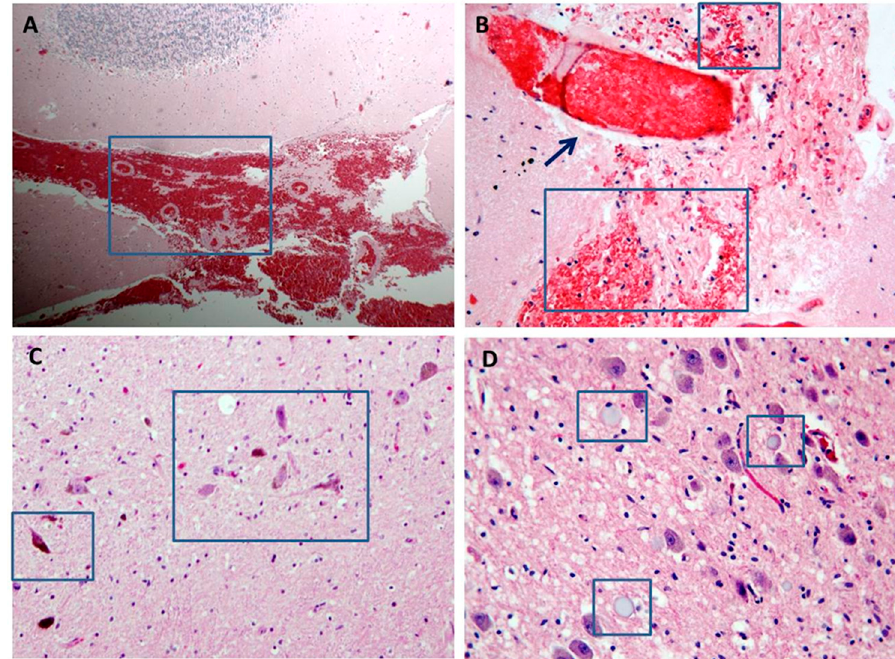
Figure 3. Brain histology from high voltage electrocution death. ( A , B ): massive cerebellar and brain hemorrhage respectively (blue box indicates the detail) with intra-vessel coagulopathy in ( B ) (black arrow indicates the detail) (H&E stain ×10 A; ×20 B). ( C ): dark neurons as sign of ischemic neuronal damage due to vasoconstriction (H&E stain ×20). ( D ): axonal balloon degeneration (blue box indicates the detail) in a context of white matter necrosis and degeneration (H&E stain ×40).